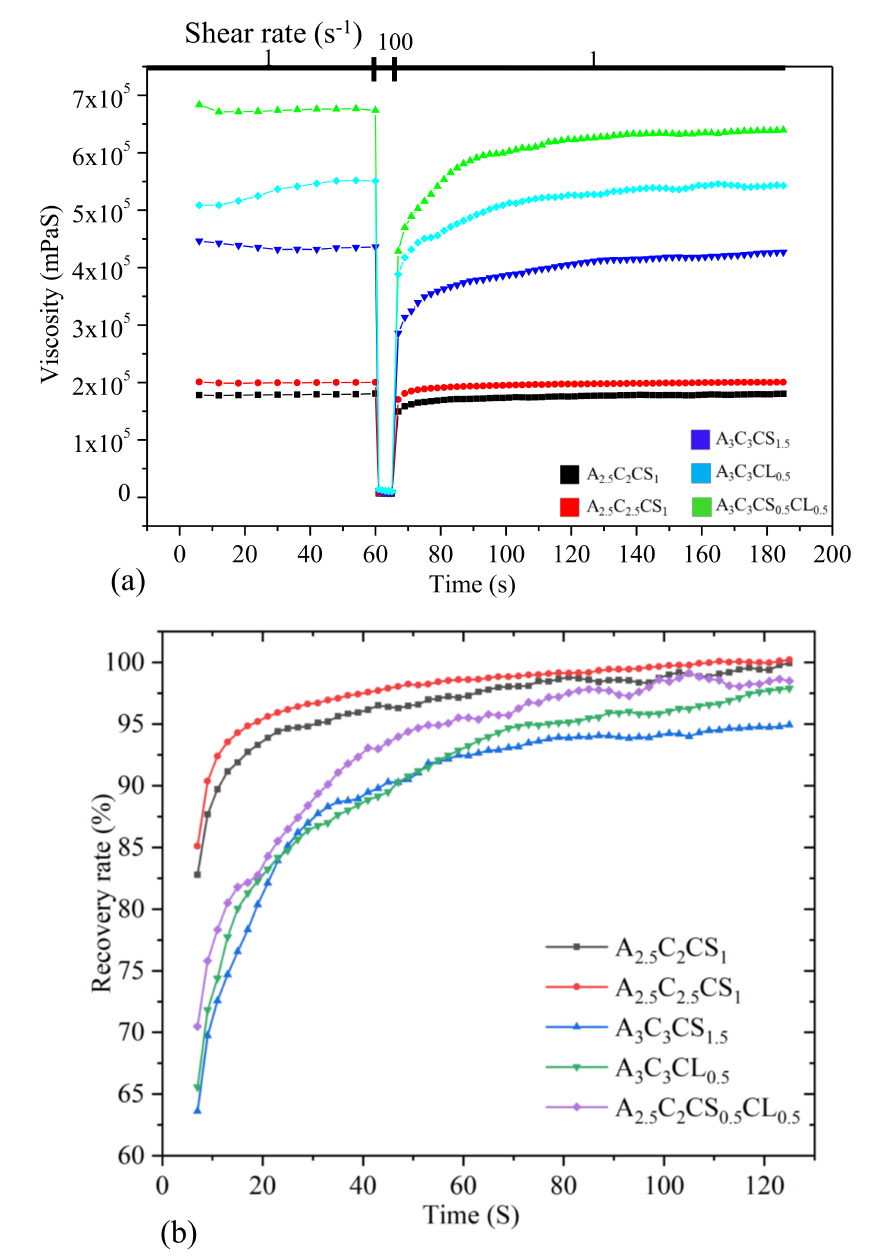
Figure 7. ( a ) Results of three-point thixotropic test and ( b ) Percentage of recovery rate for various compositions. All data points were calculated averaging three sample